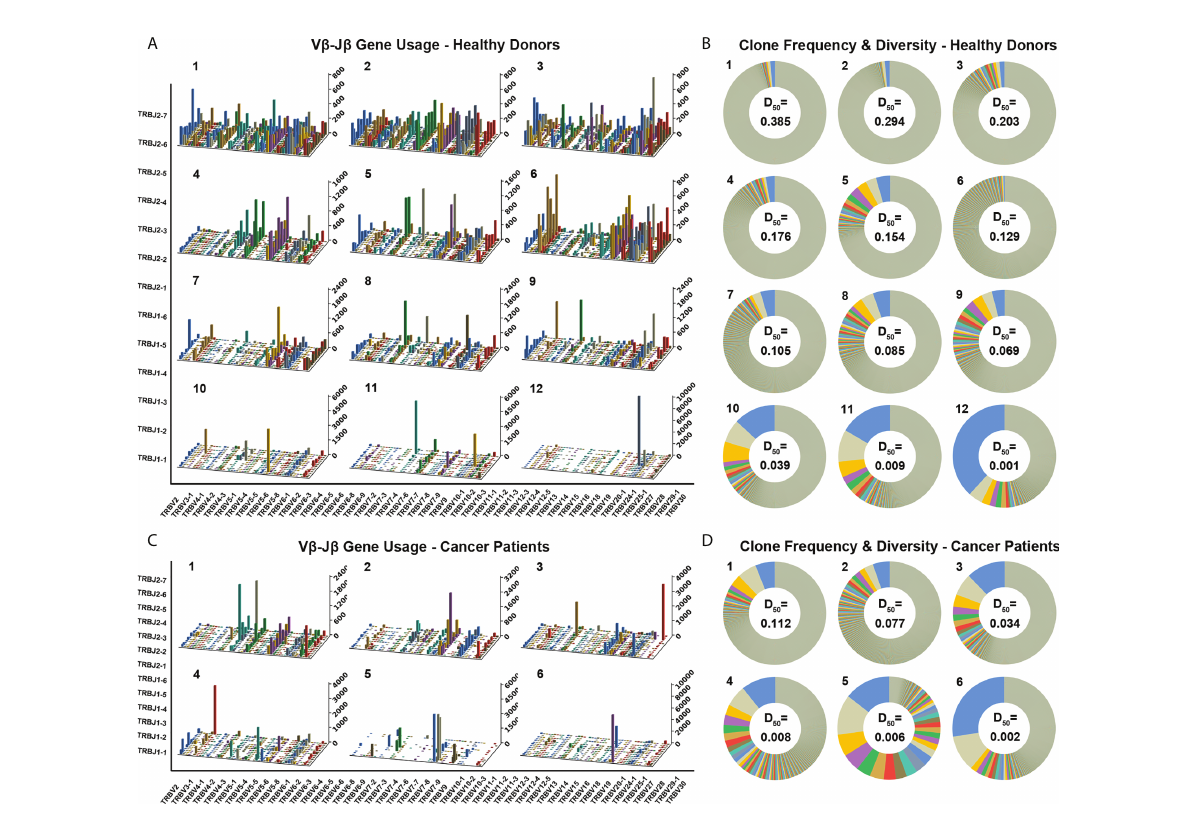
FIGURE 2 Distinct V b – J b gene usage combinations, diversities, and clonalities of expressed TCR b repertoires of healthy donors and cancer patients. (A) V – J gene usage combinations for 12 representative repertoires of healthy donors. The x-axis and y-axis depict functional human TRBV and TRBJ alleles, respectively. The z ‐ axis is the count of TCR b sequences with a given V – J combination (note the scale of z-axis varies according to changes in the maximum count). (B) Clone frequencies and diversities for the 12 representative repertoires (same as the ones shown in panel A, in the same order). The radian of a wedge on the doughnut circle indicates the percentage in the repertoire occupied by functional TCR b sequences relevant to a given CDR3 clone type (tiny clones are uniformly shown in gray). The D 50 values for each repertoire are also